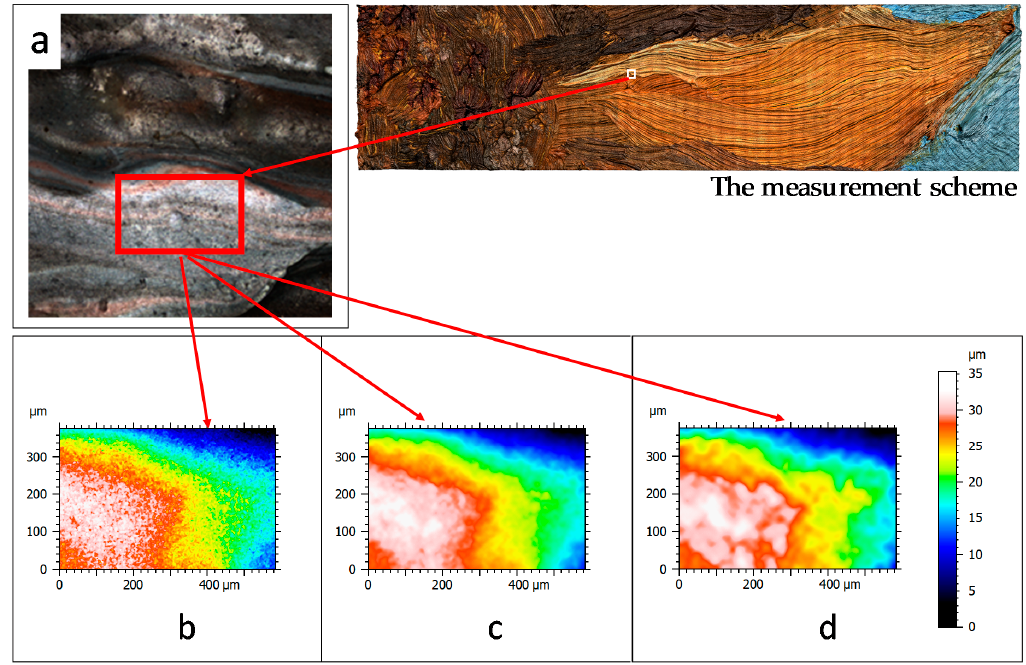
Figure 6. Height map visualization of a painting ( a ) using 10X magnification, coaxial and ring lights with a vertical resolution of 100 nm and a lateral resolution of 1.76 µm ( b ), 3 µm ( c ) and 10 µm ( d ). For the painted surface, we used 1.76 µm for lateral resolution and 100 nm for vertical resolution. This provides a good compromise between measurement time and roughness accuracy (Figure 6).